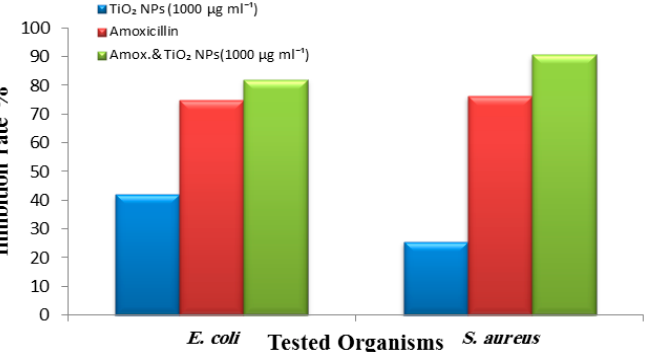
Figure 10. Inhibition rate (%) of the tested bacteria in the presence of TiO 2 NPs, amoxicillin alone